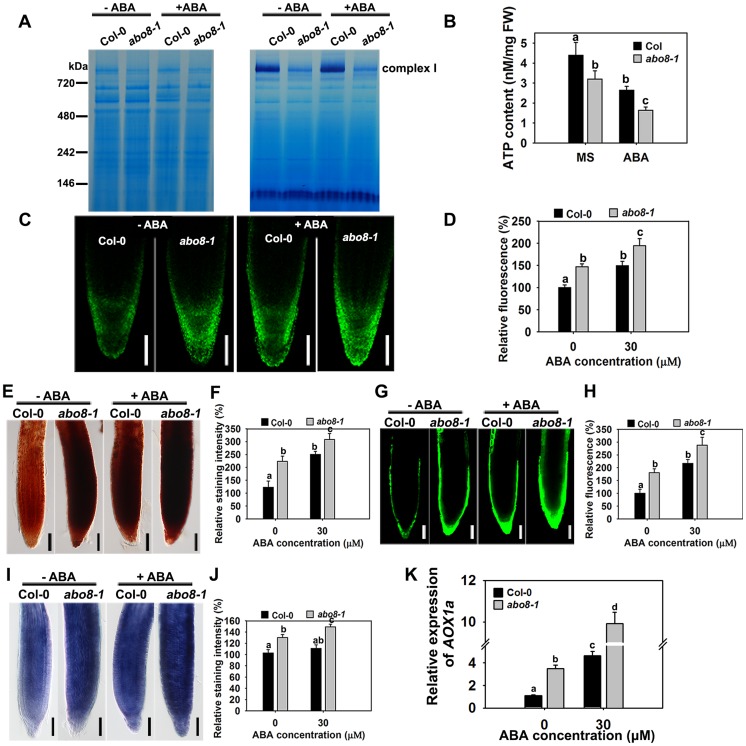

abo8-1 accumulates more ROS than the wild type in root tips.A. The activity of complex I in the wild type (WT) and abo8-1. Crude mitochondria membrane protein extracted from 5-day-old seedlings treated with or without 50 µM ABA for 24 h were separated by Blue Native-PAGE. Coomassie staining (left) indicates protein complexes after electrophoresis; Complex I activity was preformed by in-gel staining with NADH and NBT (nitroblue tetrazolium) for the NADH dehydrogenase activity of Complex I. B. ATP content in WT and abo8-1 plants. 5-day-old WT and abo8-1 seedlings treated with or without 50 µM ABA for 24 h were harvested for measurement of ATP content. FW, fresh weight. Means with different letters are significantly different at P<0.01. C. Fluorescence analysis of mitochondrial cpYFP in primary root tips of the wild type and abo8-1 with or without ABA treatment. Bars = 50 µm. D. cpYFP intensity as determined with AxioVision Rel. 4.8 software. E. DAB staining for H2O2 in primary root tips of the wild type and abo8-1 with or without ABA treatment. Bars = 50 µm. F. DAB staining intensity as determined with Adobe Photoshop 3.0 software. G. DCFH-DA staining for H2O2 in primary root tips of the wild type and abo8-1 with or without ABA treatment. Bars = 50 µm. H. DCFH-DA staining intensity as determined with AxioVision Rel. 4.8 software. I. NBT staining for superoxide in primary root tips of the wild type and abo8-1 with or without ABA treatment. Bars = 50 µm. J. NBT staining intensity as determined with Adobe Photoshop 3.0 software. Three independent experiments were done with similar results, each with three replicates, and each replicate with 15–20 roots. Values are means ±SE from one experiment. Means with different letters are significantly different at P<0.01. K. Relative expression levels of AOX1a in seedlings treated with or without 50 µM ABA for 5 h in liquid MS. Three independent experiments were done with similar results, each with three biological replicates. Results shown are from one experiment. Values are means ±SE, n = 3. Means with different letters are significantly different at P<0.01.